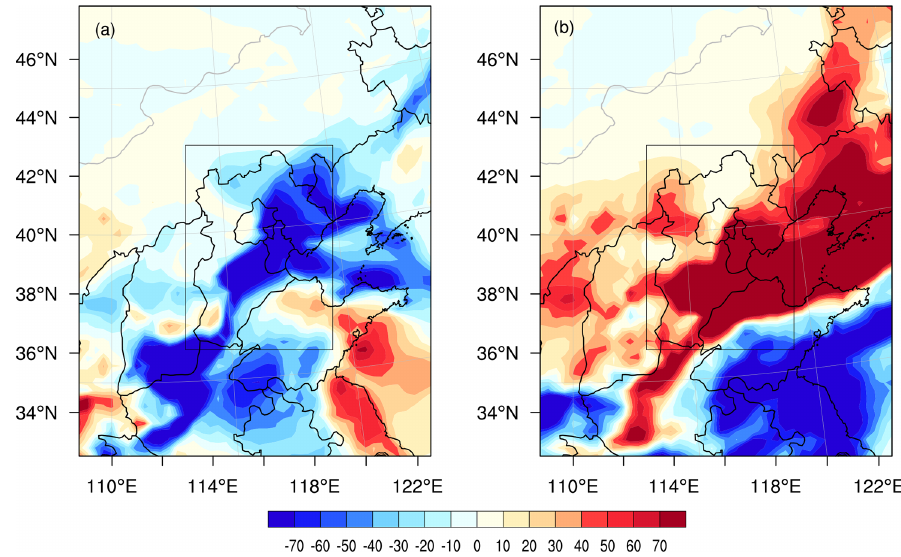
Figure 8. The spatial distributions of PM 2 . 5 forecast errors (µgm 3 ) in the control run at the (a) AT and (b) DT. The black rectangle is the verification area. Table 2. The AE V / AE M of the forecasts at the AT, with lead times of 24 and 12h, when the additional observations in the sensitive region (CNOP), Region-W and Region-N are assimilated (%). The respective optimal observation array is marked in bold. Lead times Region